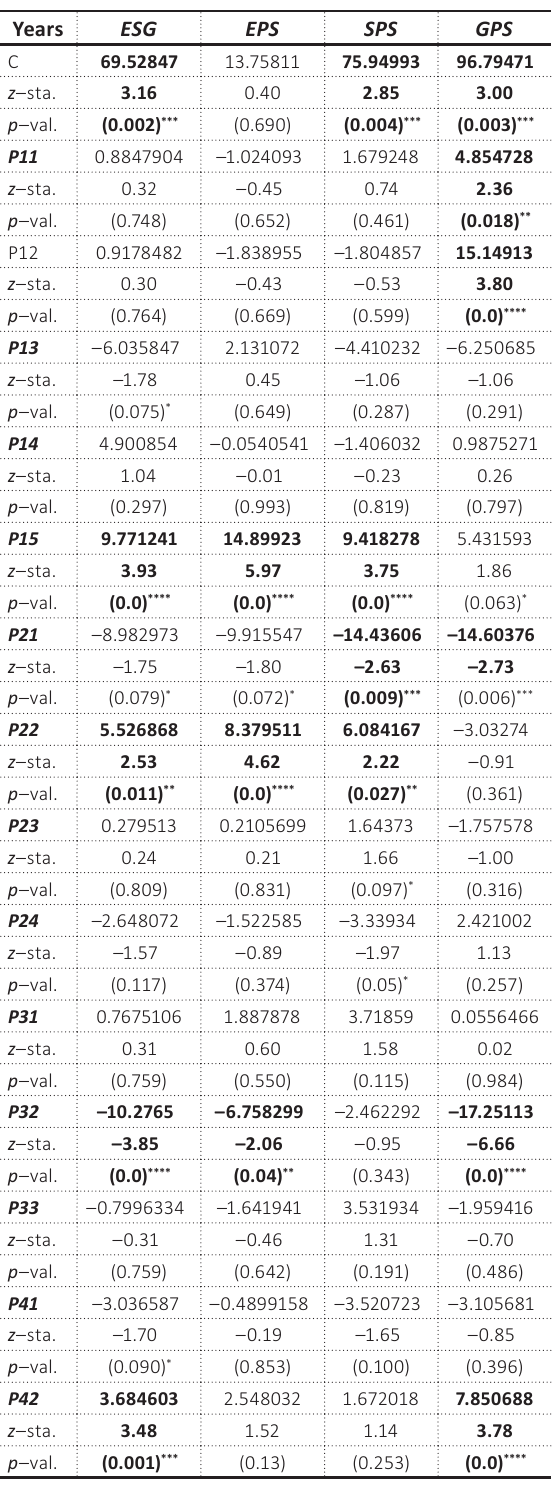
Table 3. Panel corrected standard errors (PCSE) results for ESG’s Pillars versus TTCI’